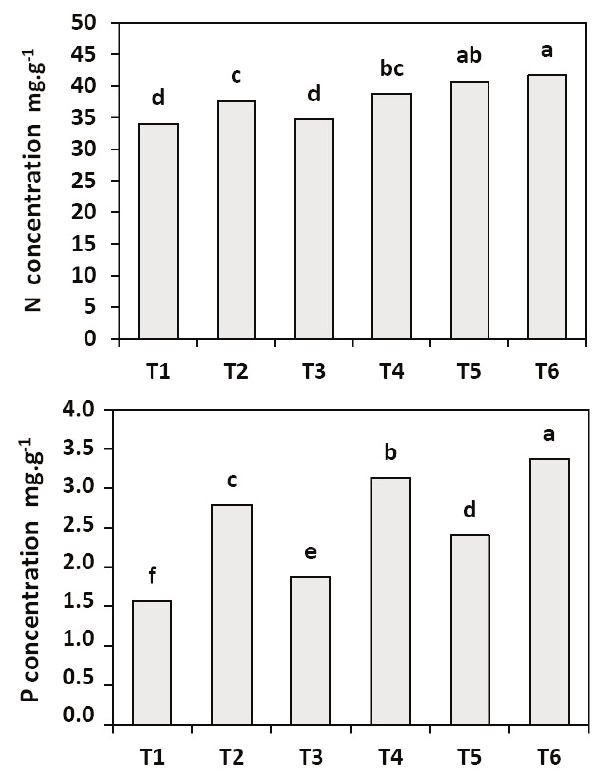
Fig. 1 - Concentrations of N and P in vegetative portion of cot- ton plants grown at different treatments (T1= no AMF without PG; T2= AMF without PG; T3= no AMF with PG; T4= AMF with PG; T5= no AMF with PG/compost; and T6= AMF with PG/compost).